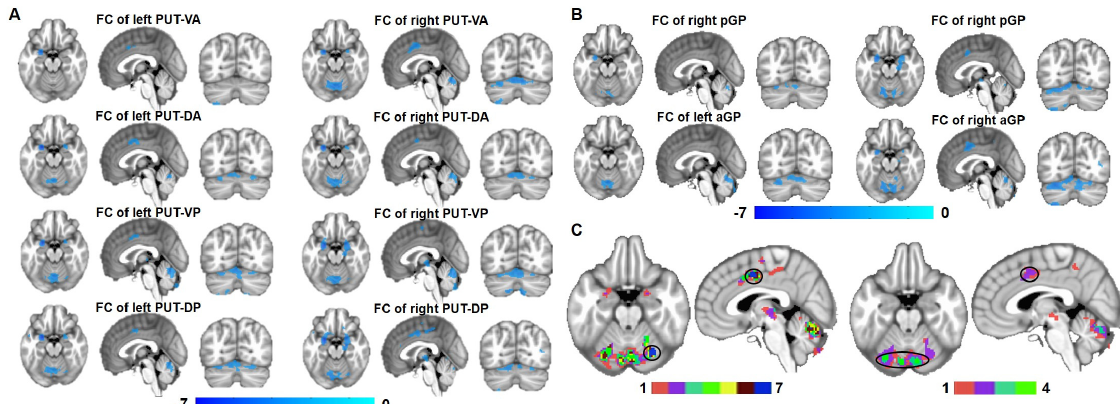
Figure 3. Group differences in FC of the lenticular nucleus. ( A ) FC changes in all subregions of the putamen between WDs and HCs. ( B ) FC changes in all subregions of the globus pallidus between WD patients and HCs. ( C ) FC changes in the eight subregions of the bilateral putamen and FC in the four subregions of the bilateral globus pallidus overlap in the MCC and cerebellum. Abbreviations: FC, functional connectivity; HCs, healthy controls; WD, Wilson’s disease. Table 2. Group FC differences in the putamen between WD patients and HCs. MNI Coordinate ROIs Regions